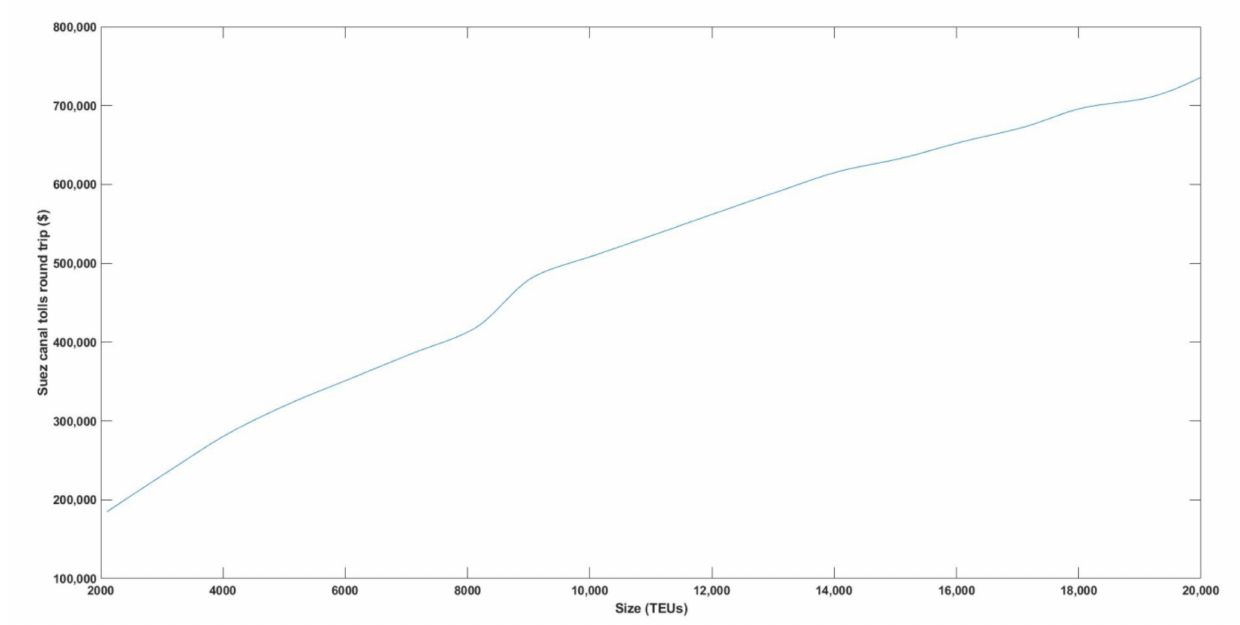
Figure 9. Suez tolls for round trip as function of size in